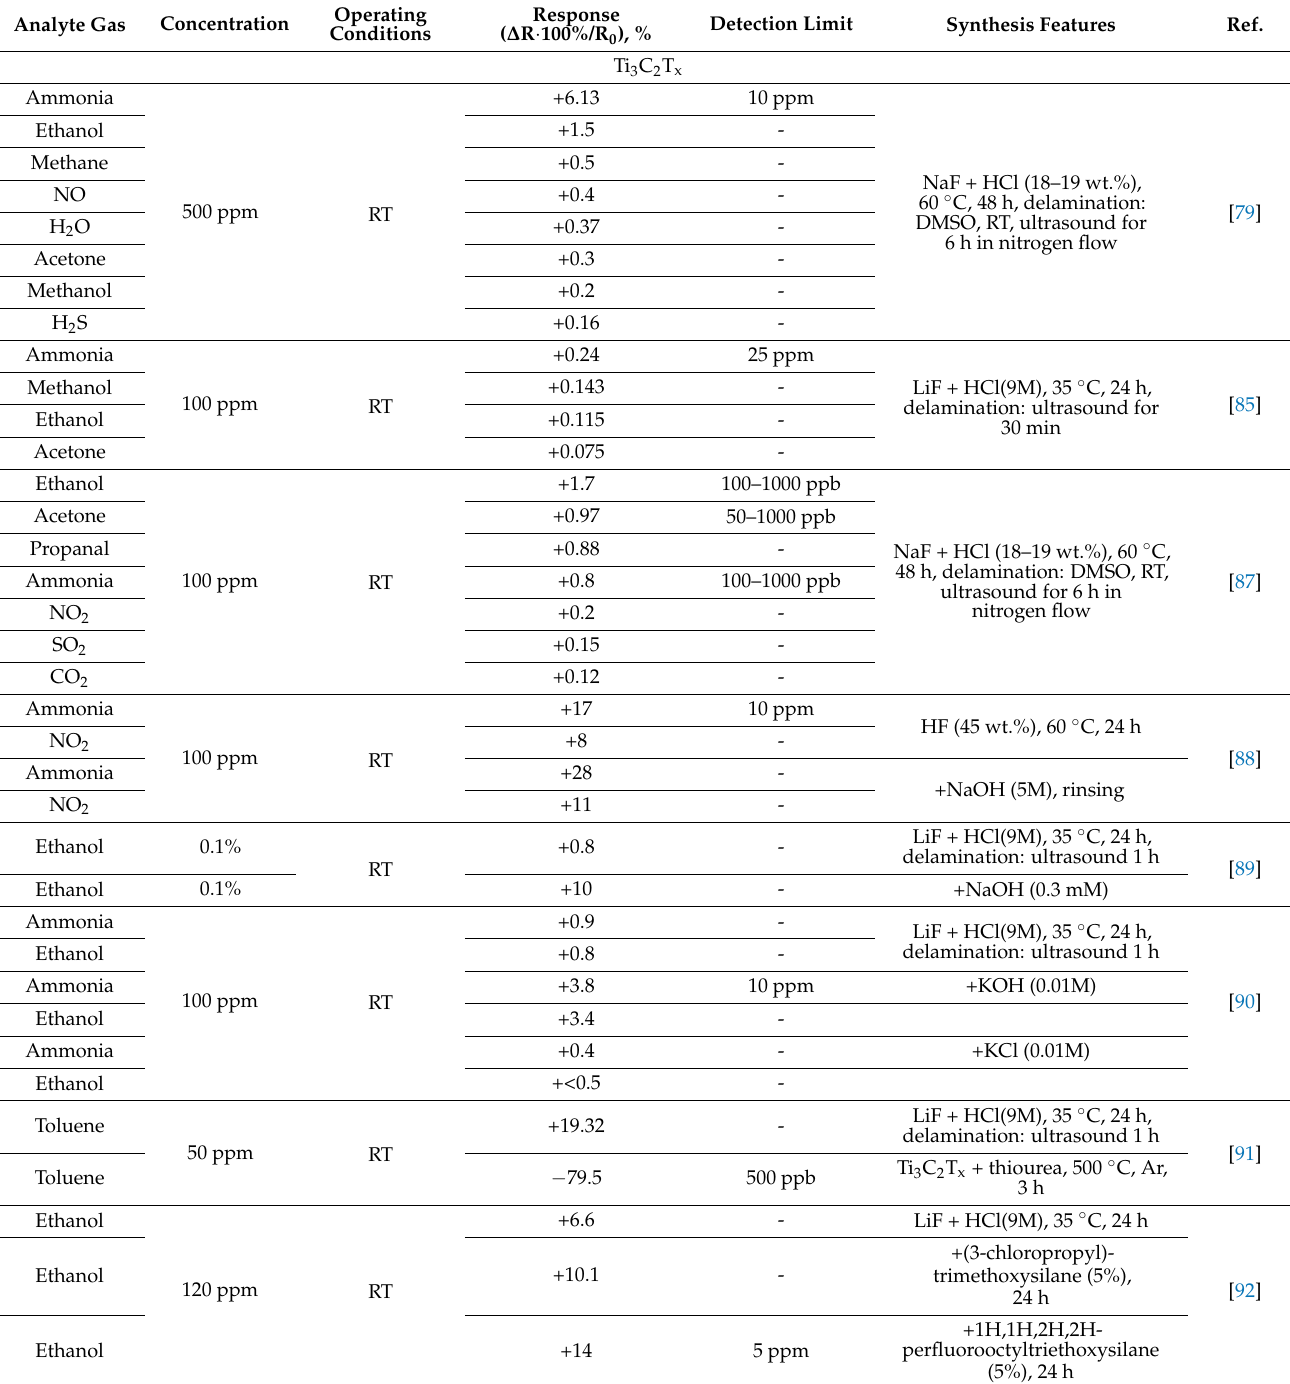
Table 1. Sensing characteristics of coatings based on individual Ti 3 C 2 T x and Ti 2 CT x